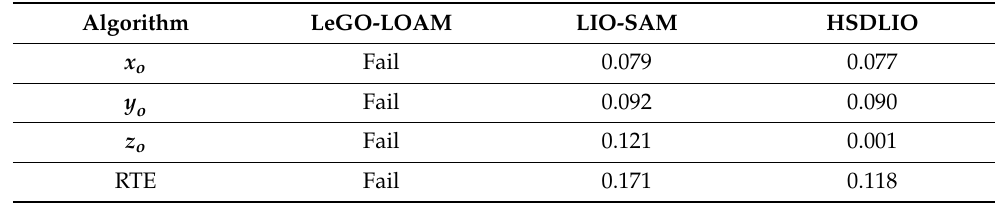
Figure 10. Comparison of LeGO-LOAM, LIO-SAM, and HSDLIO trajectories. The red line is the trajectory of HSDLIO, the blue line is the trajectory of LIO-SAM, and the black line is the trajectory of LeGO-LOAM, with the latter having drifted. Table 1. Relative translational error when the backpack returns to the starting point